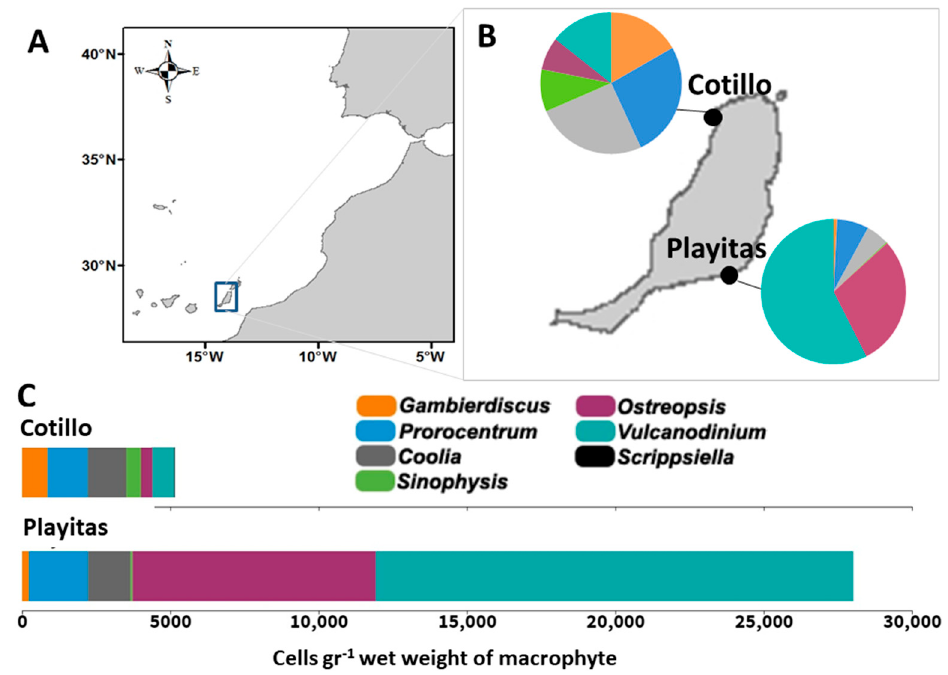
Figure 1. Location of Fuerteventura Island in the East Atlantic region ( A ). Relative ( B ) and total ( C ) mean abundances of epibenthic dinoflagellates in the two studied stations.